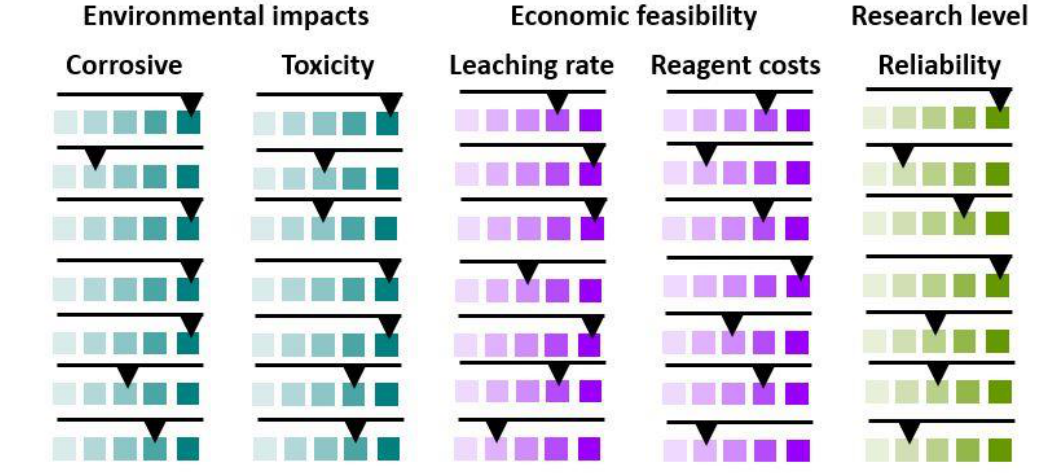
Figure 10. Basic assessment indices of different leaching methods (according to the data from